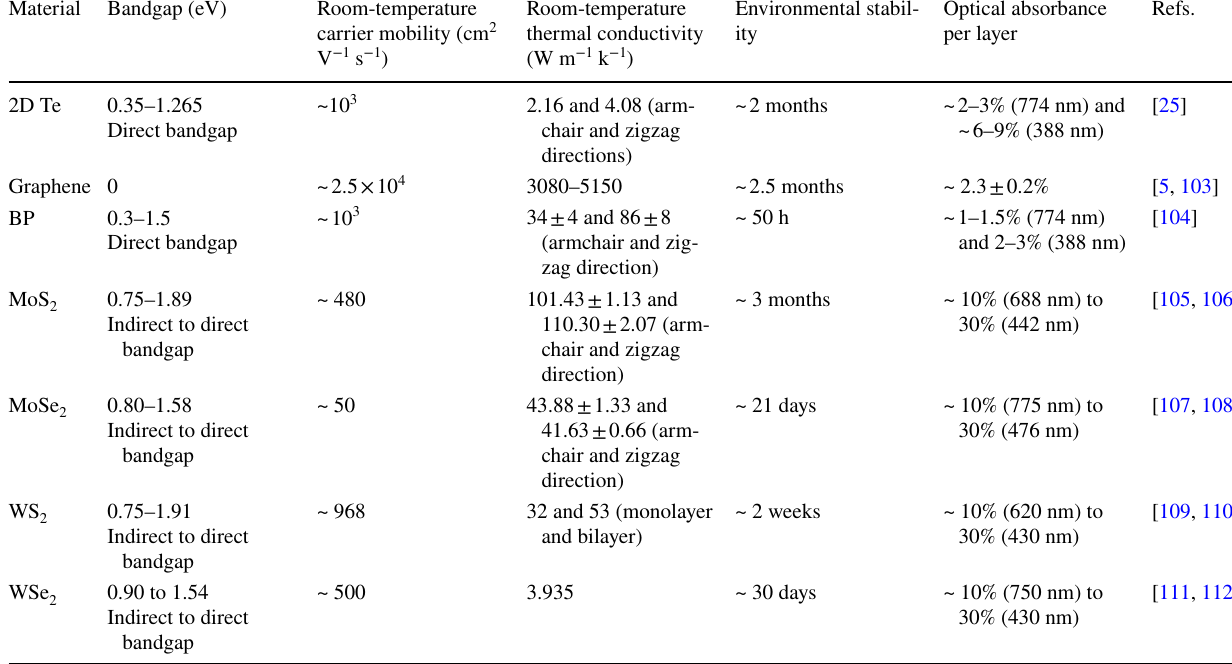
Table 1 Physical properties of 2D Te and other 2D